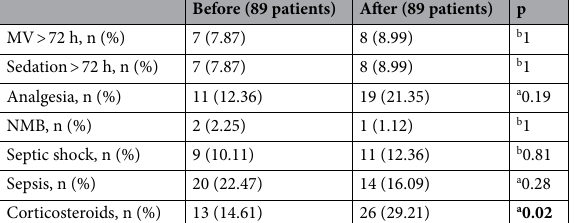
Table 2. Risk factors for ICU-AW. Bold values denote statistical significance at the p ≤ 0.05 level. MV mechanical ventilation, NMB neuromuscular blocker. a Pearson chi-square, b